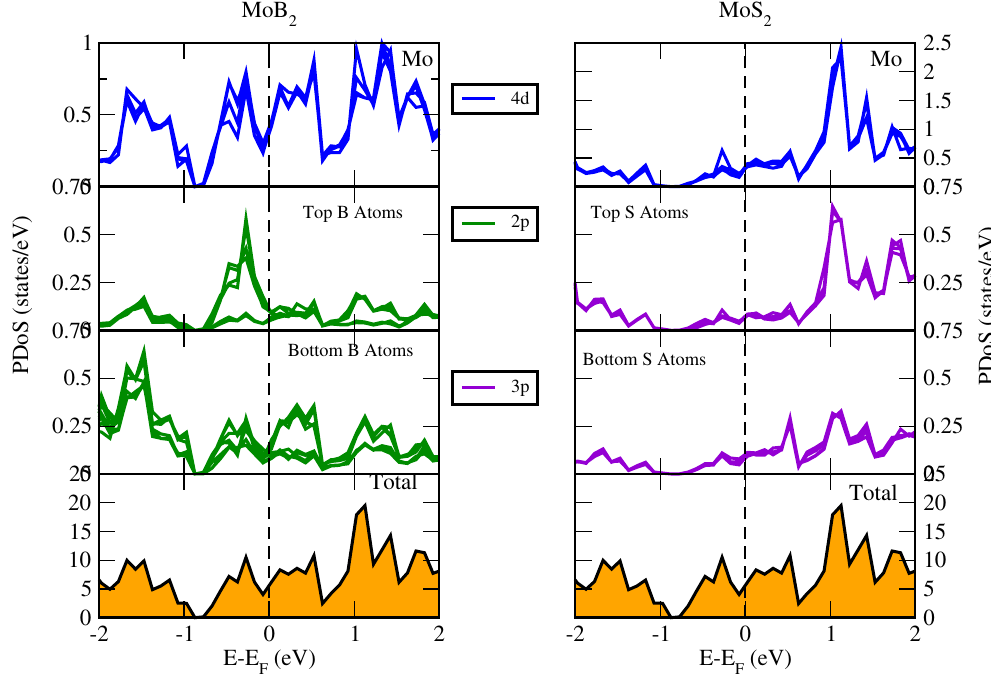
Figure 3. Projected density of states of MoS 2 / MoB 2 HS. Left panel shows the contribution of MoB 2 and right panel shows the contribution of MoS 2 in the electronic structure of HS.